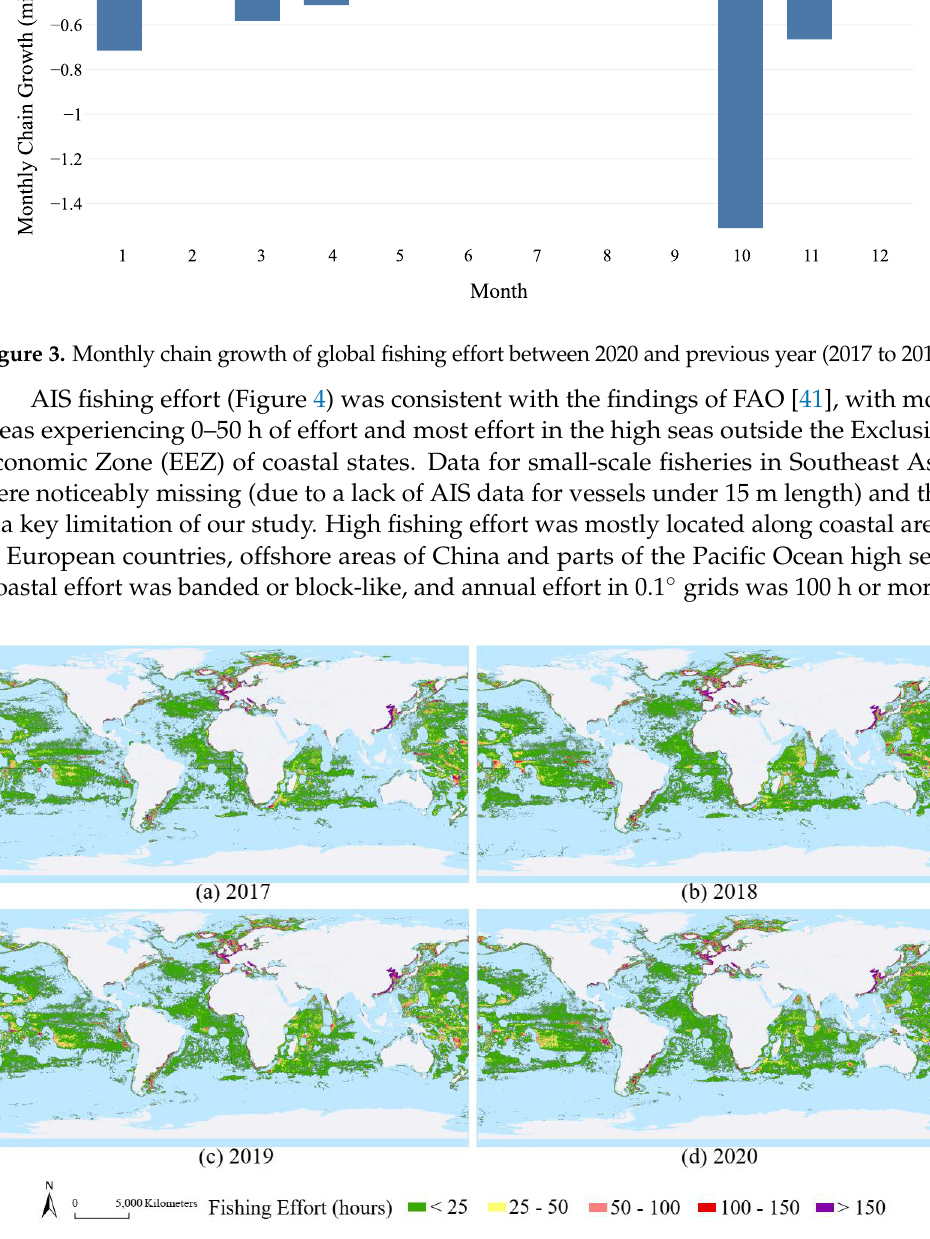
Figure 4. Spatial distribution of global AIS fishing effort from 2017 to 2020, color-coded according to the classes of fishing effort